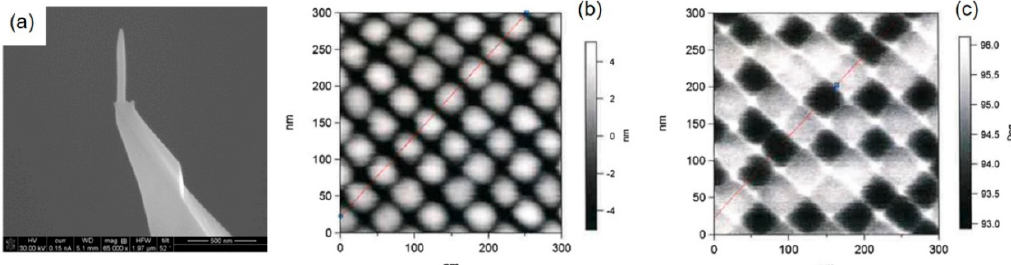
Figure 7. Sub-10 nm resolution magnetic force microscopy (MFM) imaging via FEBID super-tips. ( a ) shows a Co-based, FEBID super-tip with a metal content of ~60 at.% and end radii below 10 nm. Such tips are then used for imaging bit patterned media, as shown by the height and lift-mode phase images in ( b , c ), respectively. As evident, the MFM image ( c ) clearly reveals the written bits with lateral resolution in the sub-10 nm regime. Adapted and reprinted from Belova et al., Rev. Sci. Instrum. 2012 [111].